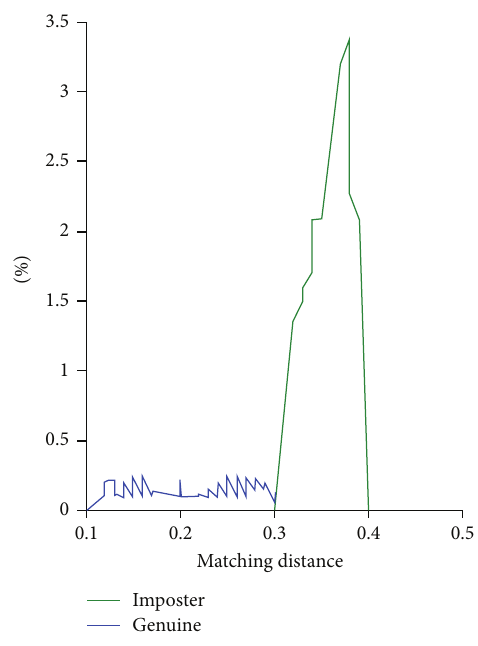
Figure20:Distancedistributionsofgenuinematchingandimposter matching of proposed DOST for PolyU palmprint database.